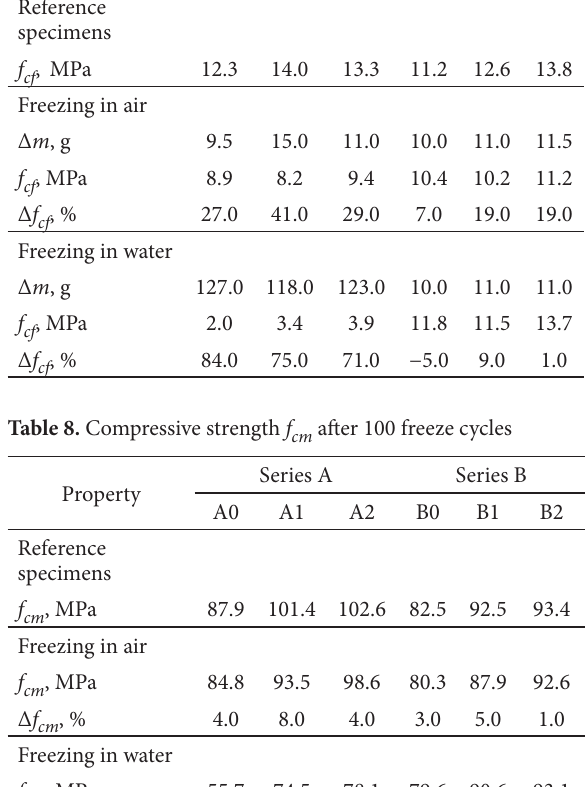
Table 7. Flexural strength f cf and change in the mass of the specimens after 100 freeze cycles Property